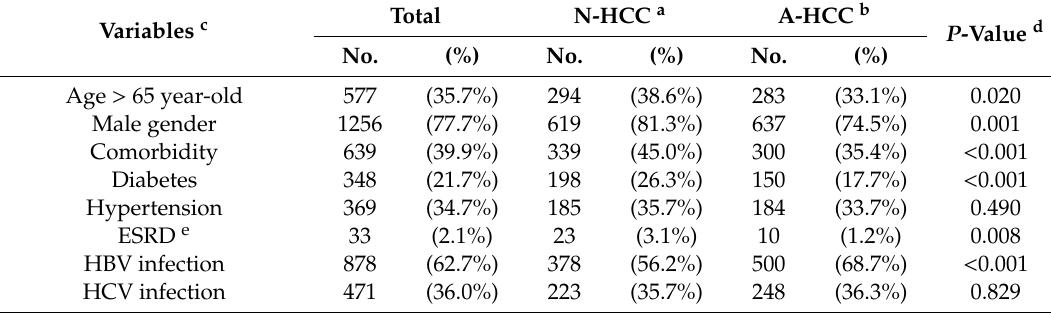
Table 1. Clinical characteristics of normal alpha-fetoprotein hepatocellular carcinoma (N-HCC) a